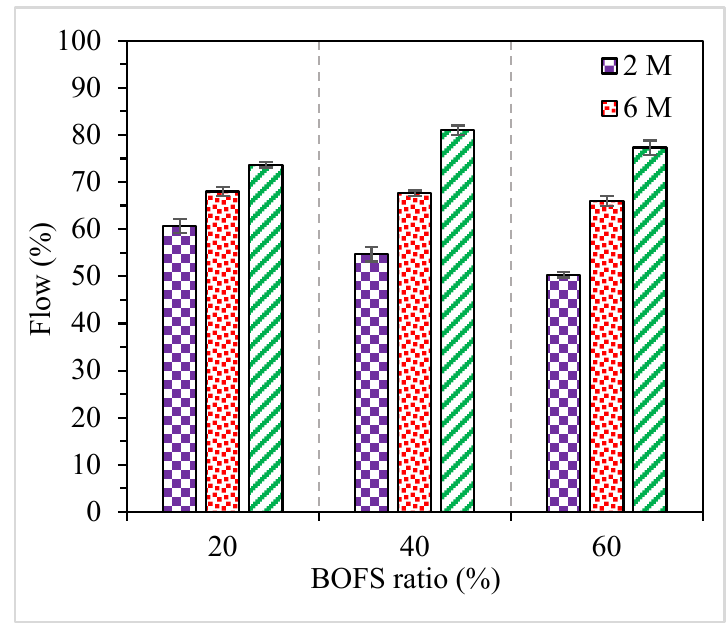
Figure 5. Flow values of AAM mixes (green is 10